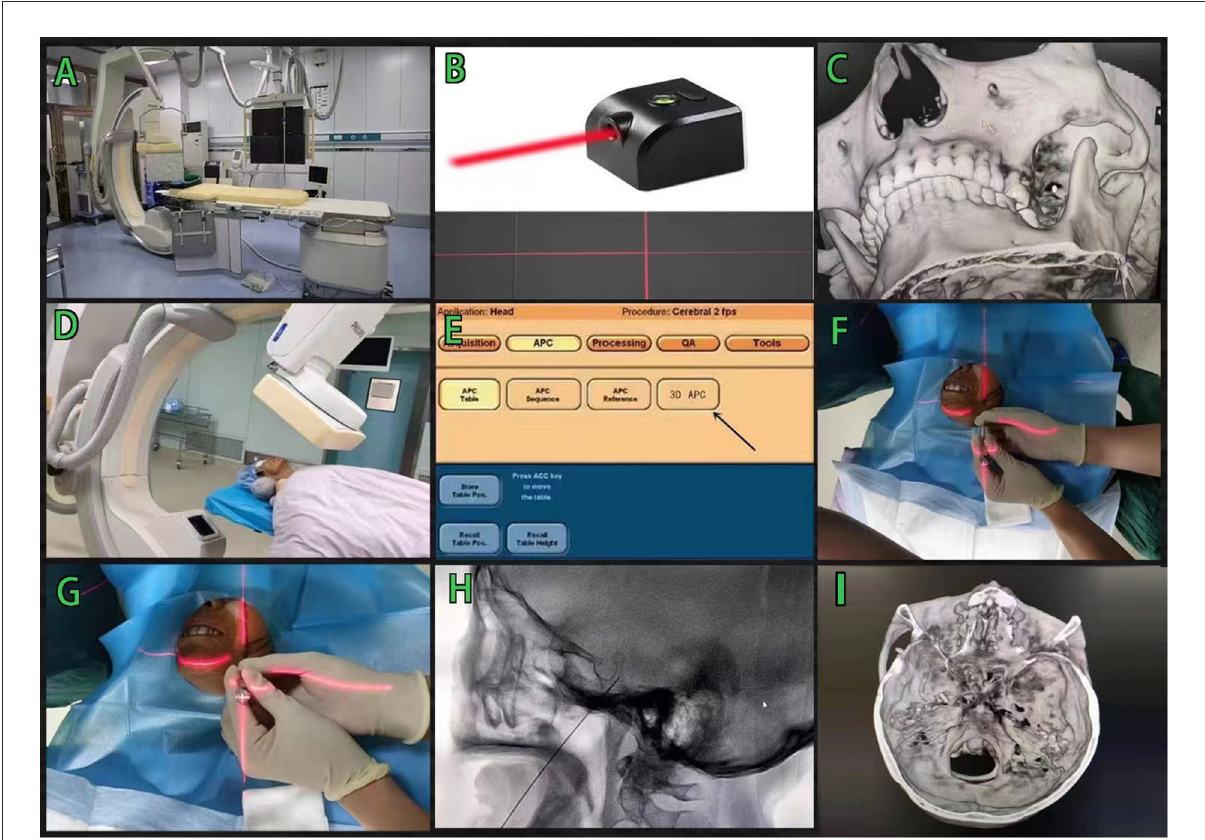
FIGURE1 Laser navigation assisted DSA radiofrequency thermocoagulation in the treatment of trigeminal neuralgia. (A,B) Philip FD20 Digital Subtraction Angiography machine and cross-laser transmitter, (C) Adjust the 3D image so that the development line overlaps with the oval foramen, (D,E) Use the 3DAPC function in the Xper-APC automatic position control module to move the rack to a specified angle, (F,G) The puncture needle is punctured in the direction of the cross laser, and (H,I) The lateral X-ray of the head was taken to verify that the tip of the needle was in the oval